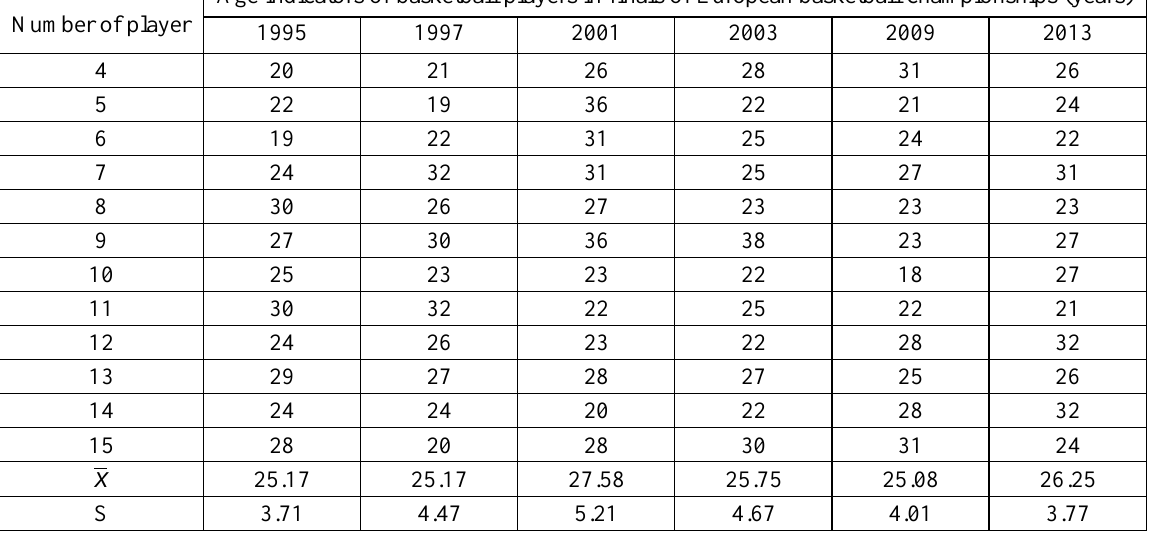
Age indicators of female basketball players of basketball combined team of Ukraine (women) in finals of European championships 1995-2013,